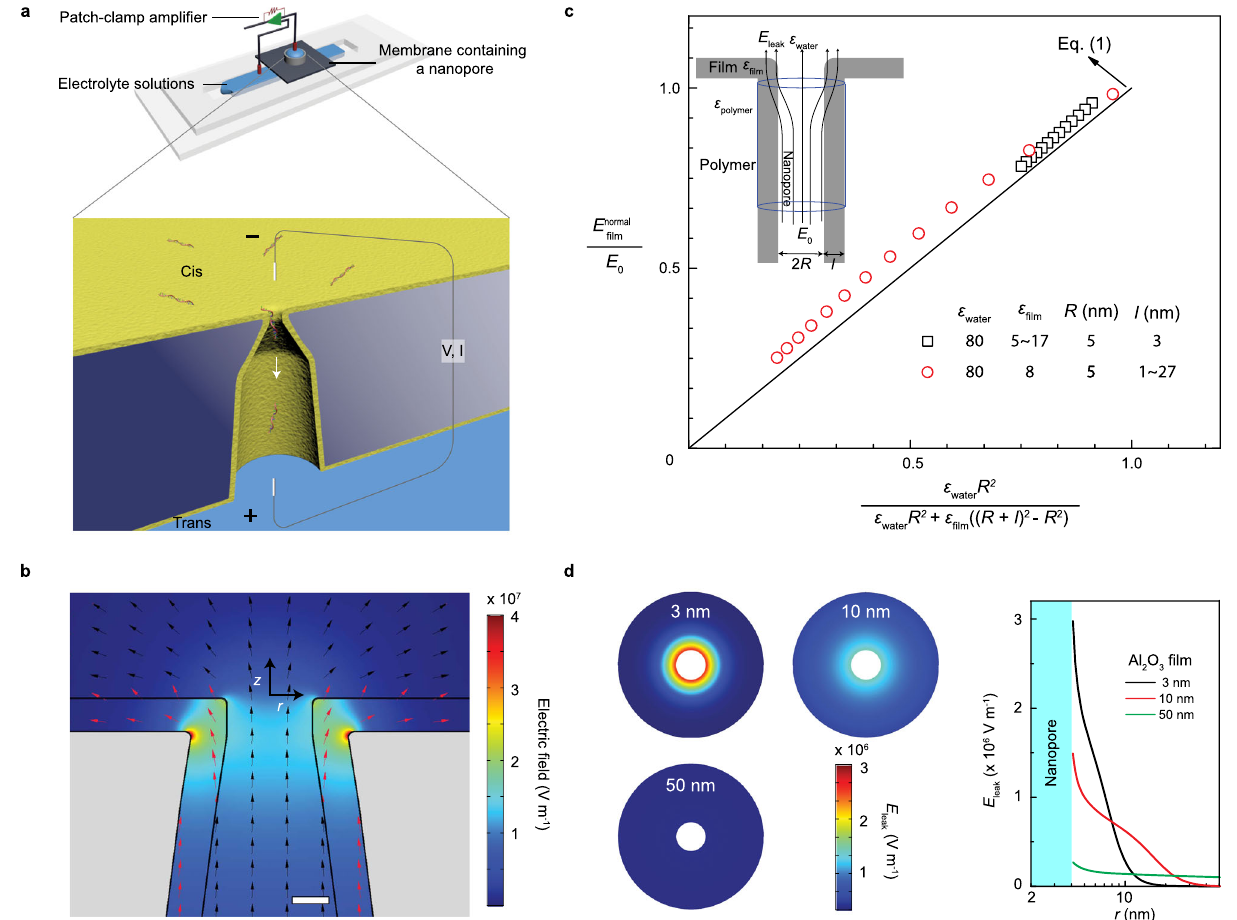
Fig. 1 The electric fi eld leakage effect in Al 2 O 3 -coated polymer nanopores. a Set-up to measure resistive pulses from the translocation of individual DNA molecules through single bullet-shaped polymer nanopore coated with a thin Al 2 O 3 layer. b Electrostatic modeling of an Al 2 O 3 -coated bullet-like nanopore (tip diameter: 8 nm, half cone angle: 8°) simulated with an applied voltage of 500 mV. Electric fi eld direction and intensity were evaluated numerically on the tip side of the Al 2 O 3 -coated polymer nanopore. The electric fi eld is signi fi cantly enhanced and develops a normal fi eld leakage near the sharp pore edge. Scale bar = 3 nm. c Validation of Eq. (1) through the use of fi nite-element-method simulations for normal fi eld leakage in the dielectric fi lm. Different permittivities (black squares, ε fi lm : 5~17) and fi lm thicknesses (red circles, l : 1~27 nm) were sampled. Inset shows the schematics of a high-permittivity dielectric fi lm on an insulating polymer nanopore ori fi ce and the Gauss volume used to estimate the leakage fi eld around the pore. d Left: Surface plots of the strength of normal leakage fi eld ( E leak ) showing the normal leakage fi eld at the pore edge is a strong function of Al 2 O 3 fi lm thickness (nanopore diameter, 8 nm). Right: Axial dependence of the normal leakage fi eld as a function of distance from the pore mouth r for three Al 2 O 3 fi lm